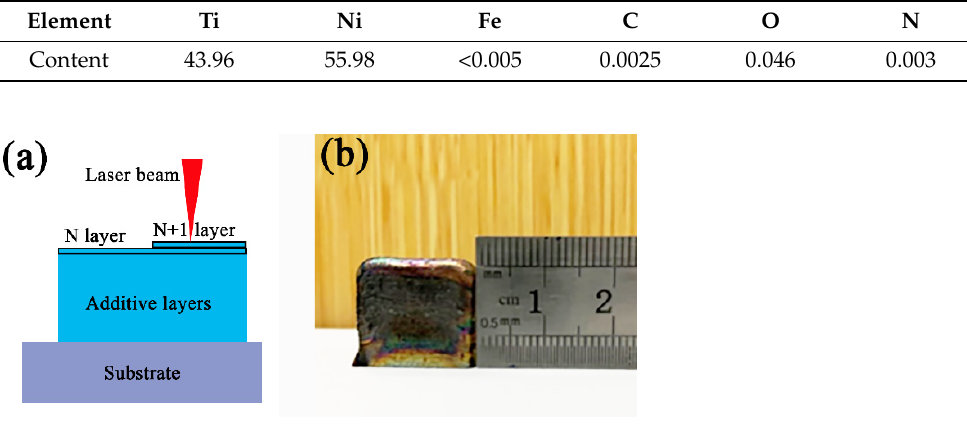
Figure 2. ( a ) XRD patterns of as-deposited Ti 49.2 Ni 50.8 ; ( b ) DSC curve of as-deposited Ti 49.2 Ni 50.8 ; ( c )